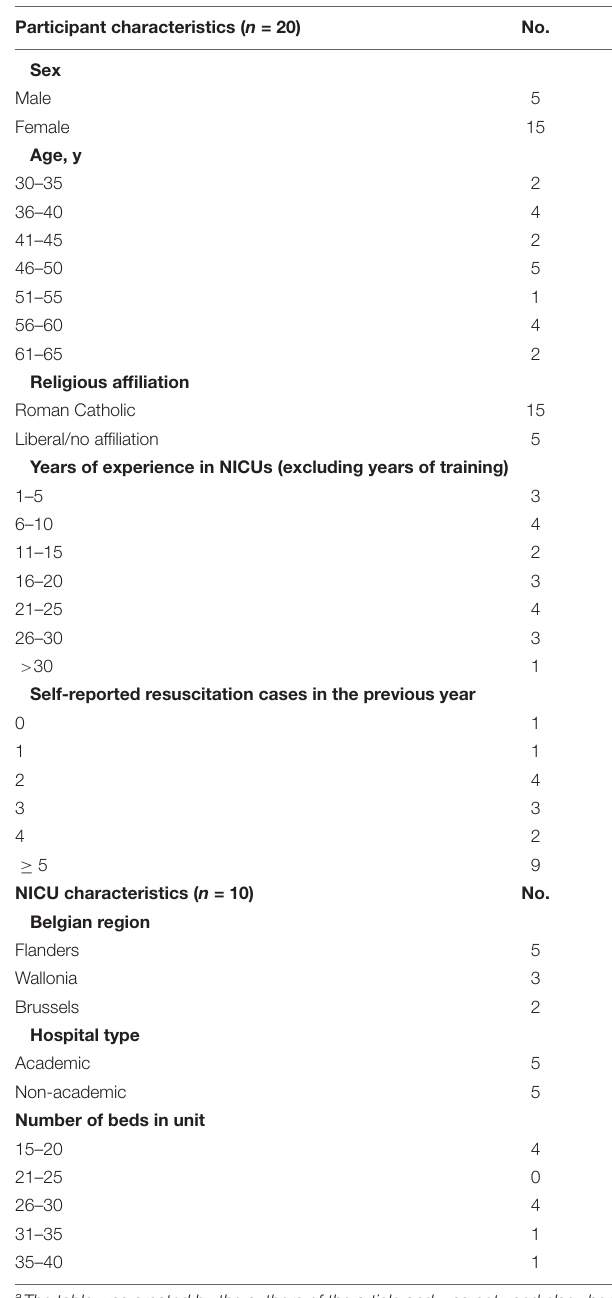
TABLE 1 | Demographics of participants and characteristics of affiliated NICUs a